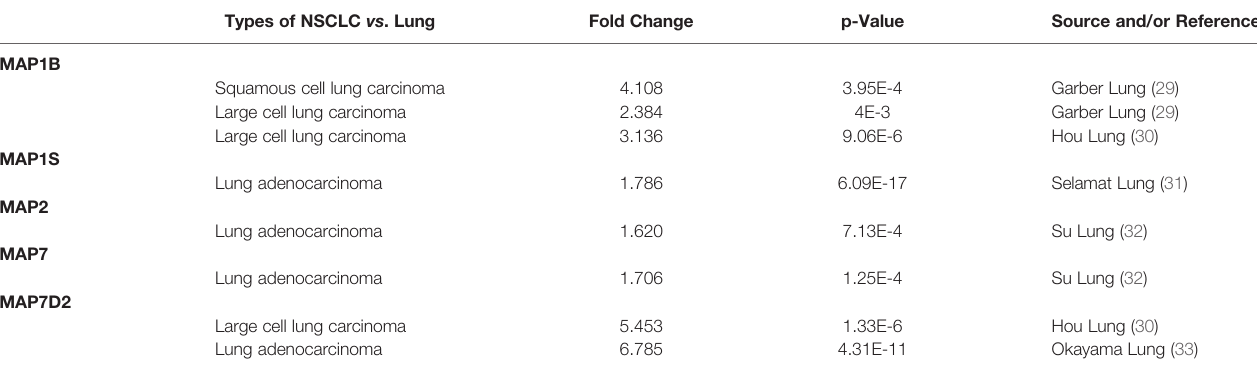
TABLE 1 | Differences in transcriptional expression of diverse MAPs between NSCLC and normal lung specimens (Oncomine Database). Types of NSCLC vs .